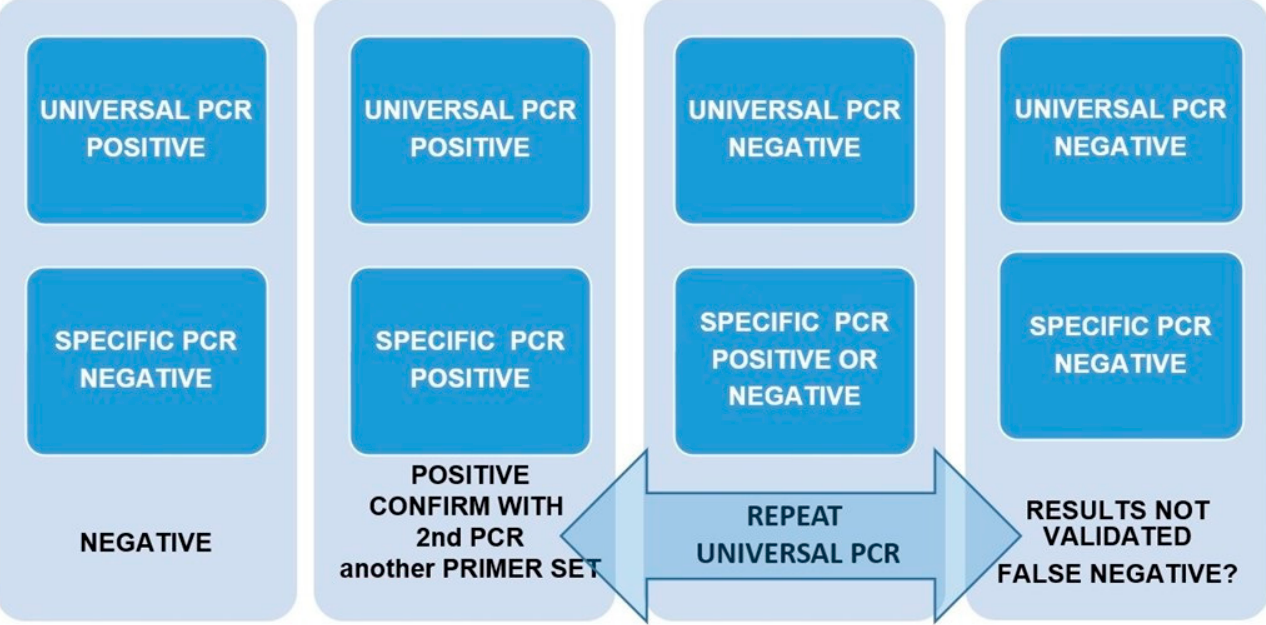
Figure 2. Pipeline designed to produce and validate results considering the amplifications of a bullfrog-specific PCR (specific PCR) and an amphibian universal PCR (universal PCR). Although not found in this study, if both universal and specific PCRs resulted in negative results, they could not be